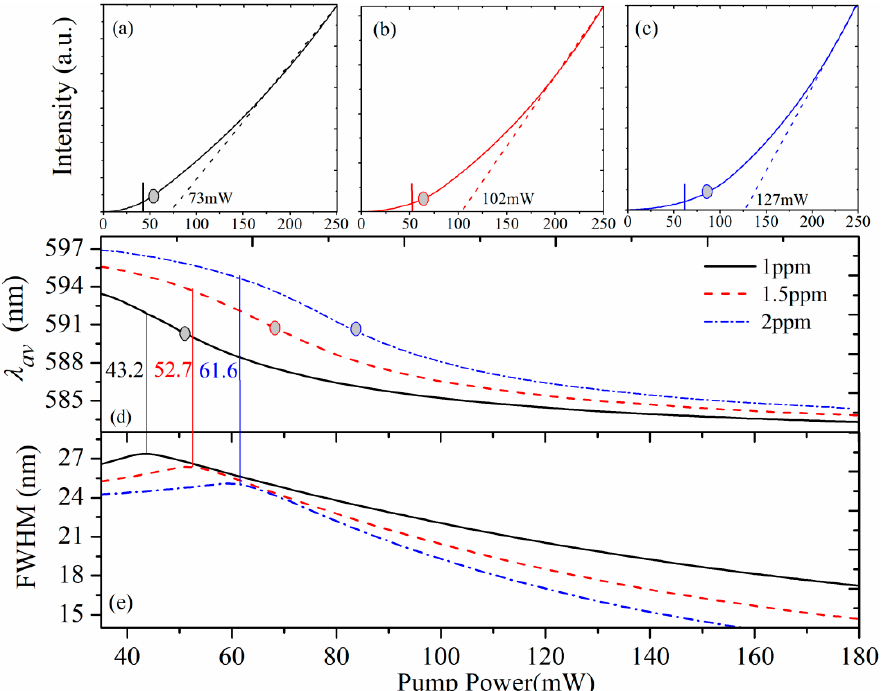
Figure 11. The output light intensity at the end of the 17-cm-long POFs with concentrations of (a) 1ppm, (b) 1.5ppm and (c) 2ppm.The corresponding λ av (d) and FWHM (e)of the output light as a function of the pump power.